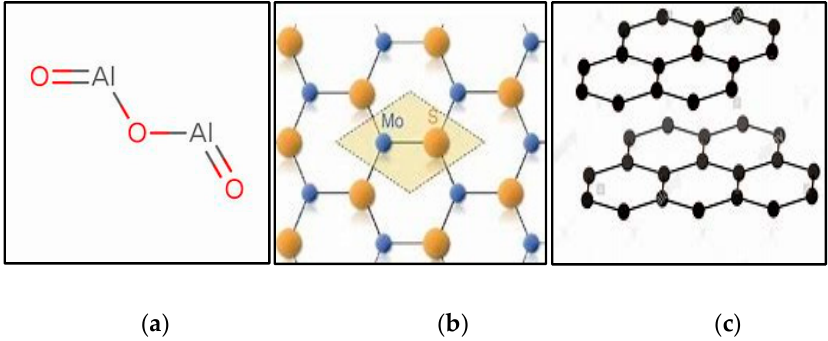
Figure 6. Atomic structure of the used nanoadditives. ( a ) Alumina structure; ( b ) MoS 2 structure; ( c ) Graphite structure.